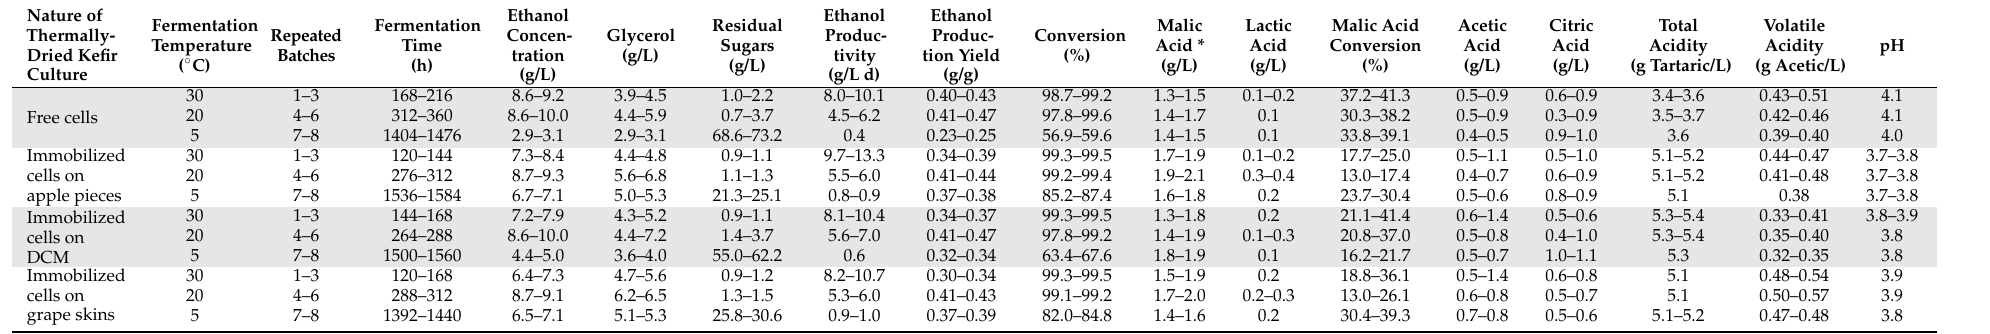
Table 2. Kinetic parameters and organic acid profile of low alcohol wines fermented by repeated batch fermentations at various temperatures (5–30 ◦ C) using thermally-dried free or immobilized kefir